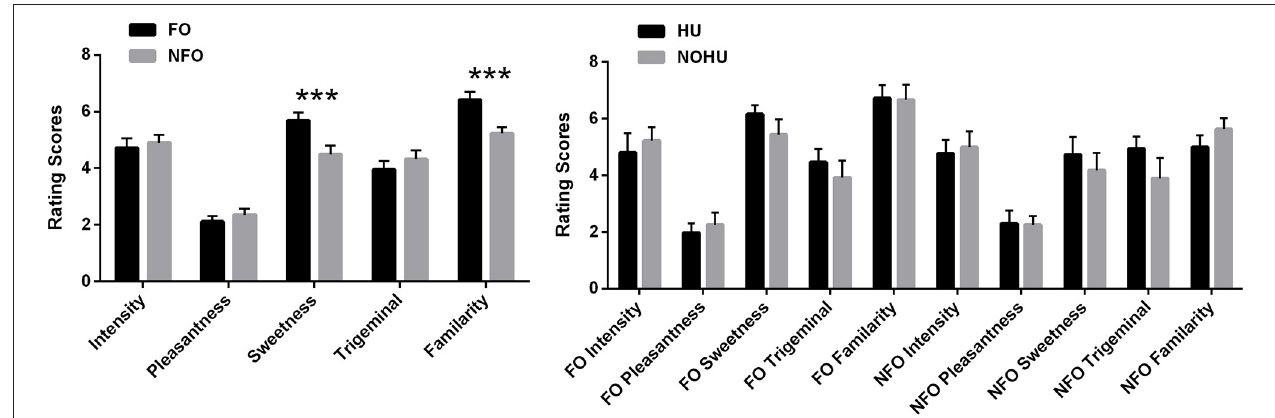
FIGURE 1 | Psychophysical ratings of odors (means and standard error of the mean): (A) FO and NFO; (B) HU ( n = 10) and NOHU ( n = 9) groups. FO, Food Odors; NFO, Non-food Odors; HU, Hunger group; NOHU, Non-hunger group. Asterisks indicate significant differences: *** p < 0.001.